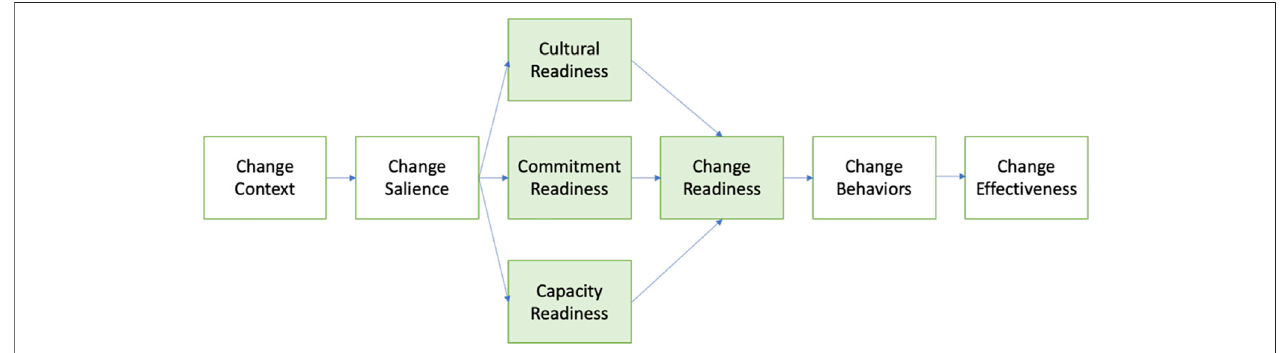
FIGURE 1 | A process for change readiness (adapted from Combe,